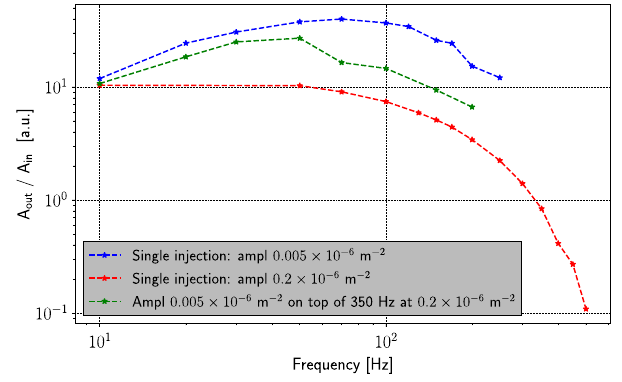
FIG. 5. The blue and red curves show respectively the linear transfer function and the 0 . 2 × 10 − 6 m − 2 fixed amplitude one, referring to Fig. 2. The green curve shows the transfer function for linear ripples injected together with a 350 Hz modulation at a nonlinear amplitude of 0 . 2 × 10 − 6 m − 2 .